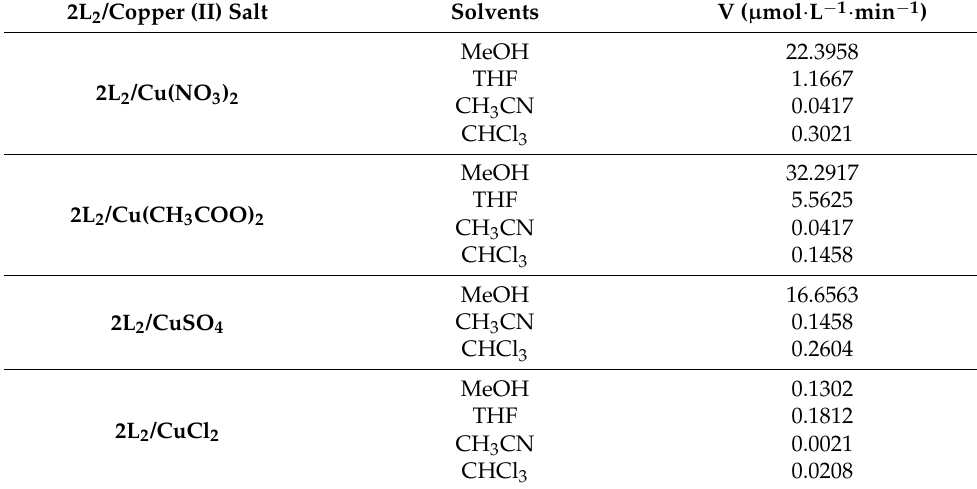
Table 3. Catechol oxidation rates for combinations (2L/1M) in different